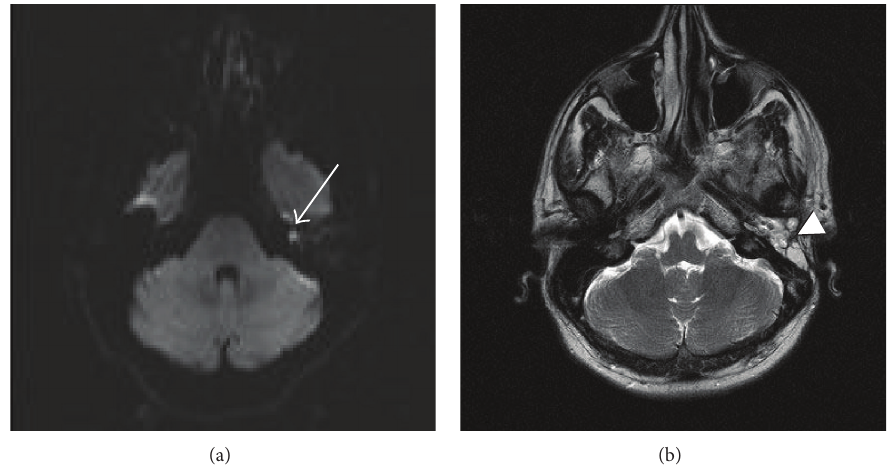
Figure 13: Recurrent cholesteatoma. Axial diffusion-weighted image (a) demonstrates abnormal hyperintense signal in the left temporal bone consistent with a focus on recurrent cholesteatoma (white arrow). Axial T2-weighted sequence (b) shows fat packing material in the left temporal bone (arrowhead) following mastoidectomy with blind sac closure.